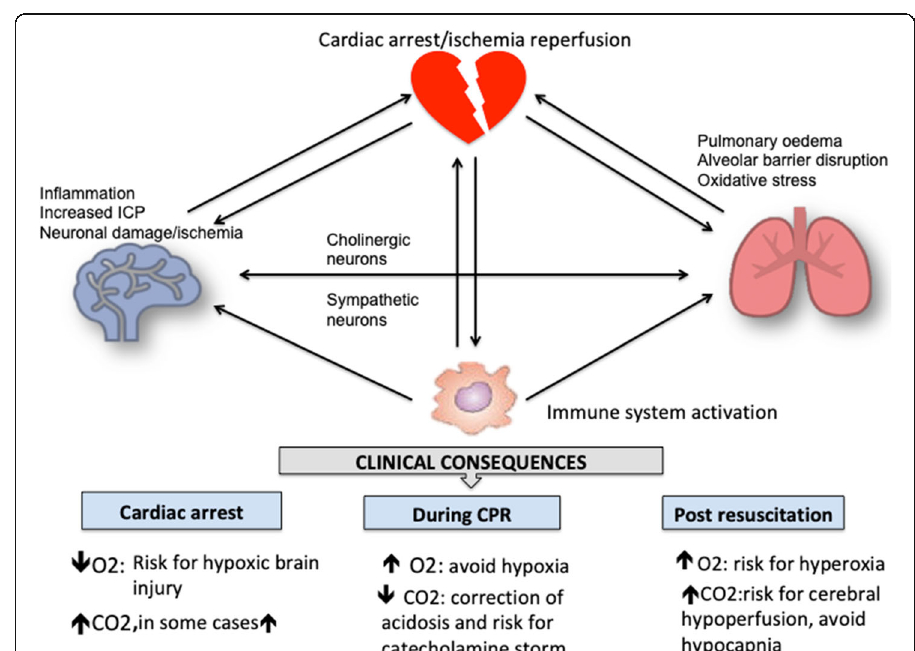
Fig. 5 Systemic effect of cardiac arrest and clinical implications in the ventilator targets to achieve. Catecholamine release, with impaired mitochondrial metabolism, can activate immunology response. Neuronal and immune responses are rapidly activated during cardiac arrest and trigger a pathway of systemic neuroendocrine and immune responses which have important systemic consequences. Global cerebral ischemia and immunological disturbances induce microgliosis, damage of blood-brain barrier, and cerebrovascular system. Endothelial dysfunction and blood brain barrier permeability are crucial in above pathological processes. The brain-lung or brain-heart-lung couplings and their disturbances may be considered as modulator of post ischemic injury, peripheral inflammation, and multiorgan dysfunction, observed in post cardiac arrest patients. Post ischemic induction of necrosis, apoptosis, and systemic inflammation predisposes to neuronal damage and poor recovery. Pulmonary complications following cardiac arrest, through cerebral ischemia or immunological activation, can result in neurogenic pulmonary edema, ARDS, or pneumonia. The clinical consequences of these pathophysiological pathways are different according to three different phases: cardiac arrest, cardiopulmonary resuscitation, and post resuscitation. ARDS, acute respiratory distress